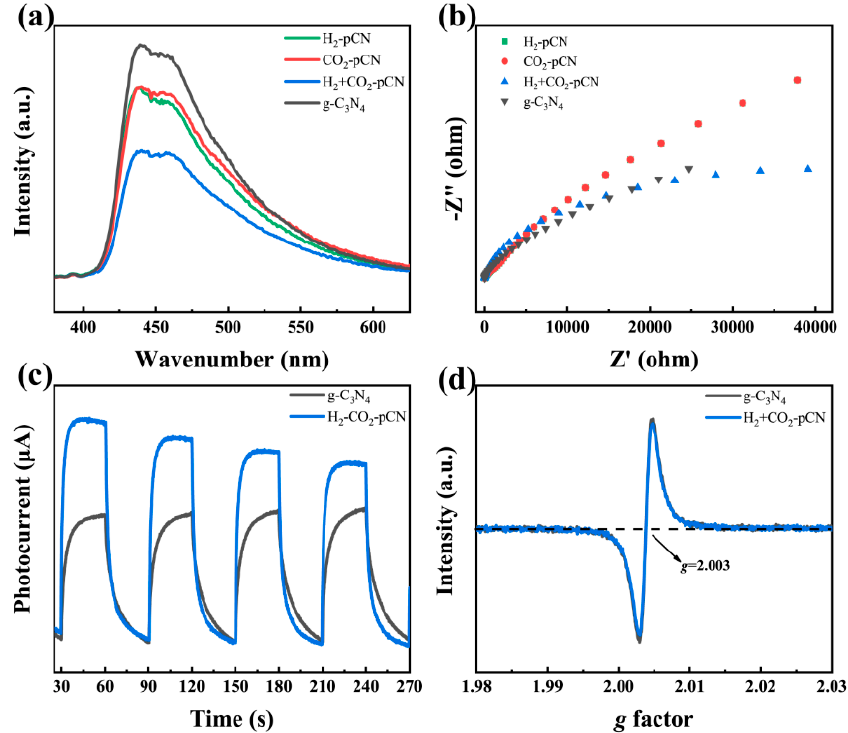
Figure 6. ( a ) PL and ( b ) EIS spectra of all samples. ( c ) Photocurrent curves and ( d ) EPR spectra of raw g-C 3 N 4 and H 2 +CO 2